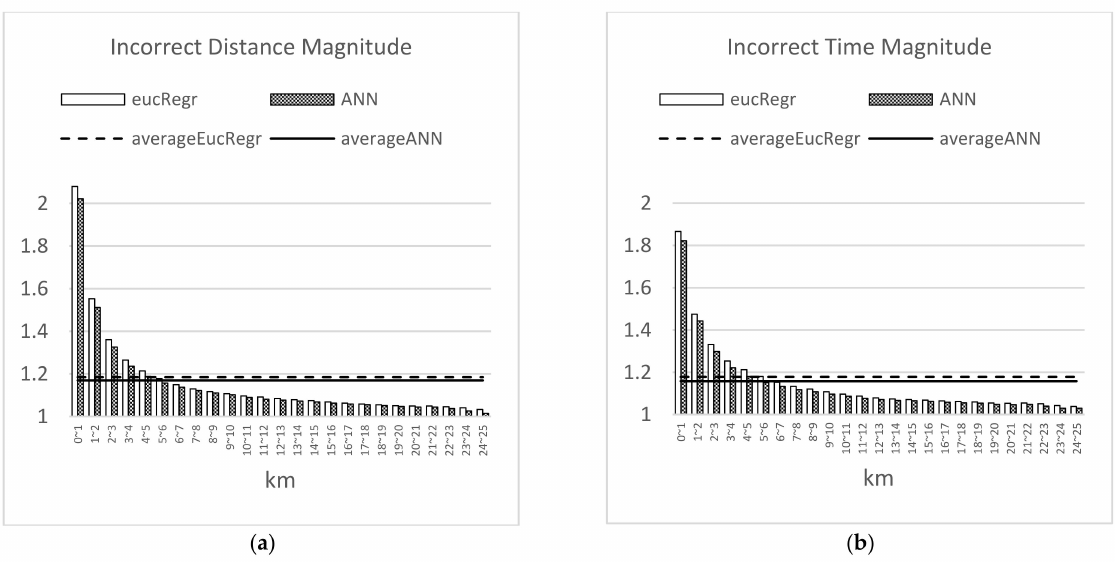
Figure 7. Magnitude of estimations being wrong in closeness measure. ( a ) Distance measure. ( b ) Time